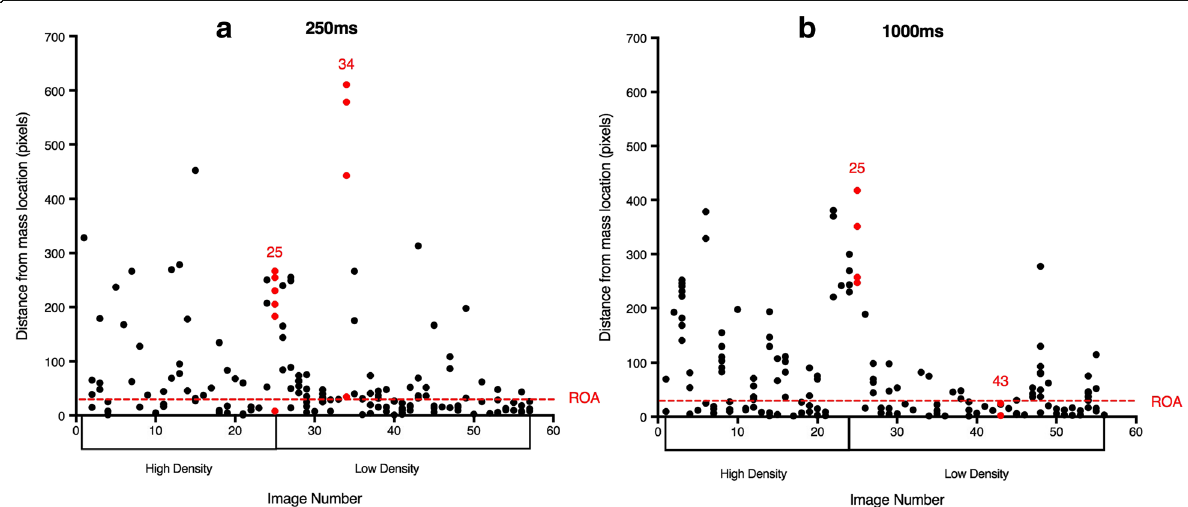
Fig. 6 Localisation errors showing the distance between the localisation response and the mass for each image (detection correct target-present trials only). a 250 ms duration; b 1000 ms duration. The x-axis represents the images (divided by high and low density. Note: the image numbers are arbitrary for the purpose of the graph only). A correct score on localisation would score 0 (excluded from the figure). The y-axis is the distance (in pixels) from the mass border. The dashed red line represents the region of acceptance (ROA). Red numbers are data points in response to images with unusual characteristics: 25 (250 ms) is the high-density image presented in Fig. 5b showing the mouse-clicks on a distractor. 34 is a low-density image which contained a prominent lymph node in the axillary tail of the breast which appears to have captured four radiologists ’ attention; 25 (1000 ms) is a low-density image containing a small mass and 43 is the low-density image presented in Fig. 5a showing the cluster of mouse-clicks near the correct location